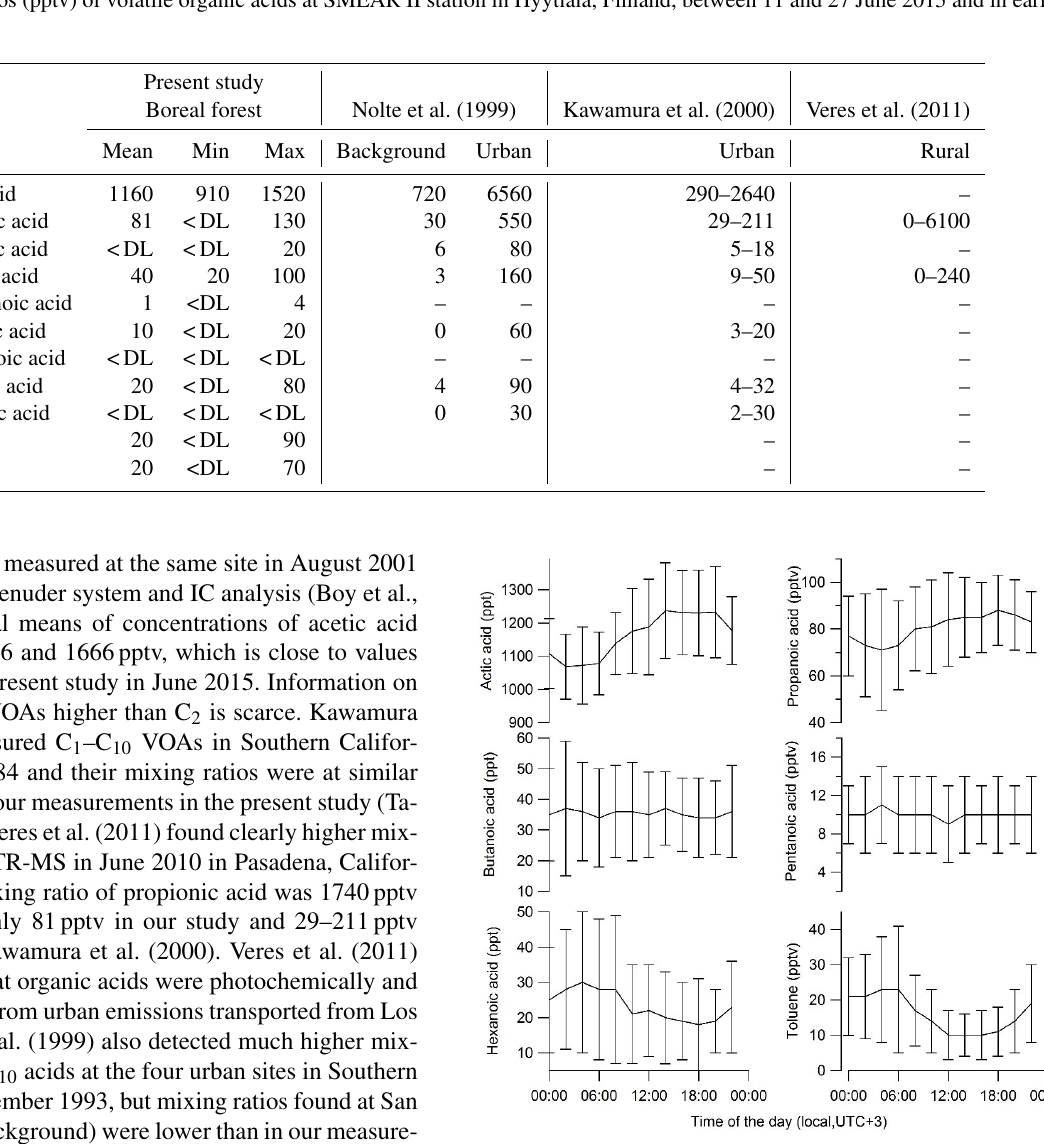
Figure 2. Mean diurnal variation of the mixing ratios with standard deviations (error bars) at SMEAR II between 11 and 27 June